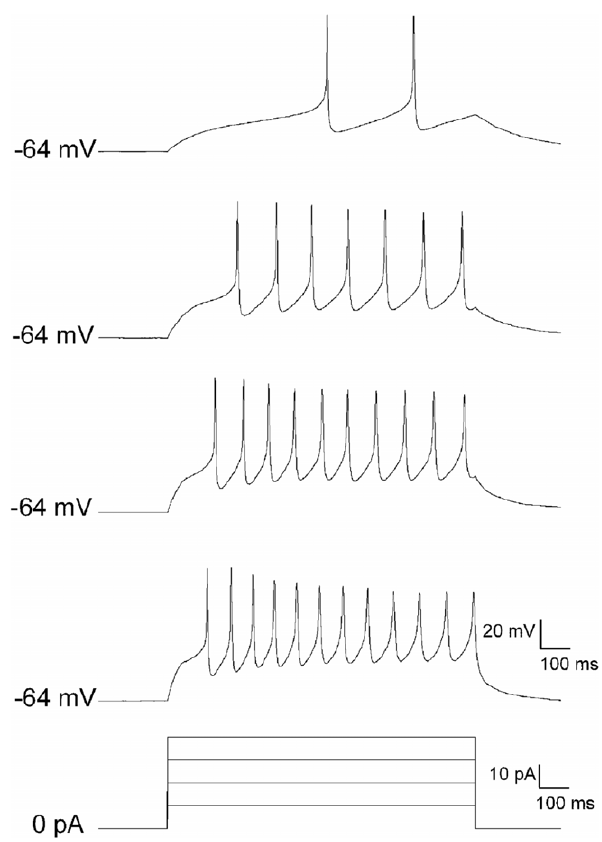
Figure 3. Electrical activity of retinoic acid-differentiated NTERA2 neurons. Representative traces from a cell exhibiting a tonic pattern of action potential discharge in response to direct current injections of 10 pA (top) to 40 pA (10 pA steps; 1 sec duration) from the resting membrane potential.